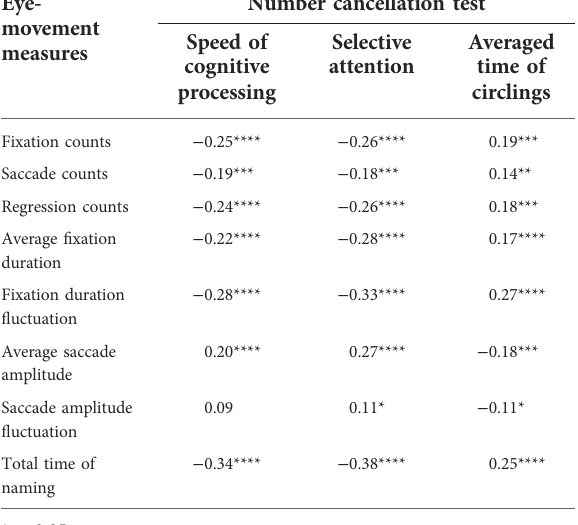
TABLE 3 Correlation between number-cancellation-related skills and eye-movement measures in task